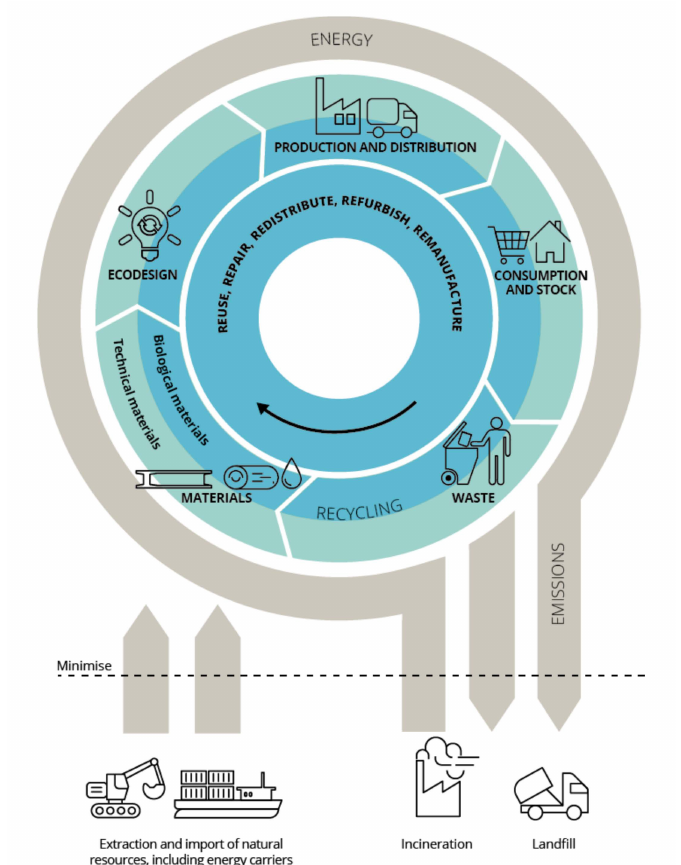
Figure 2. The process of circular economy